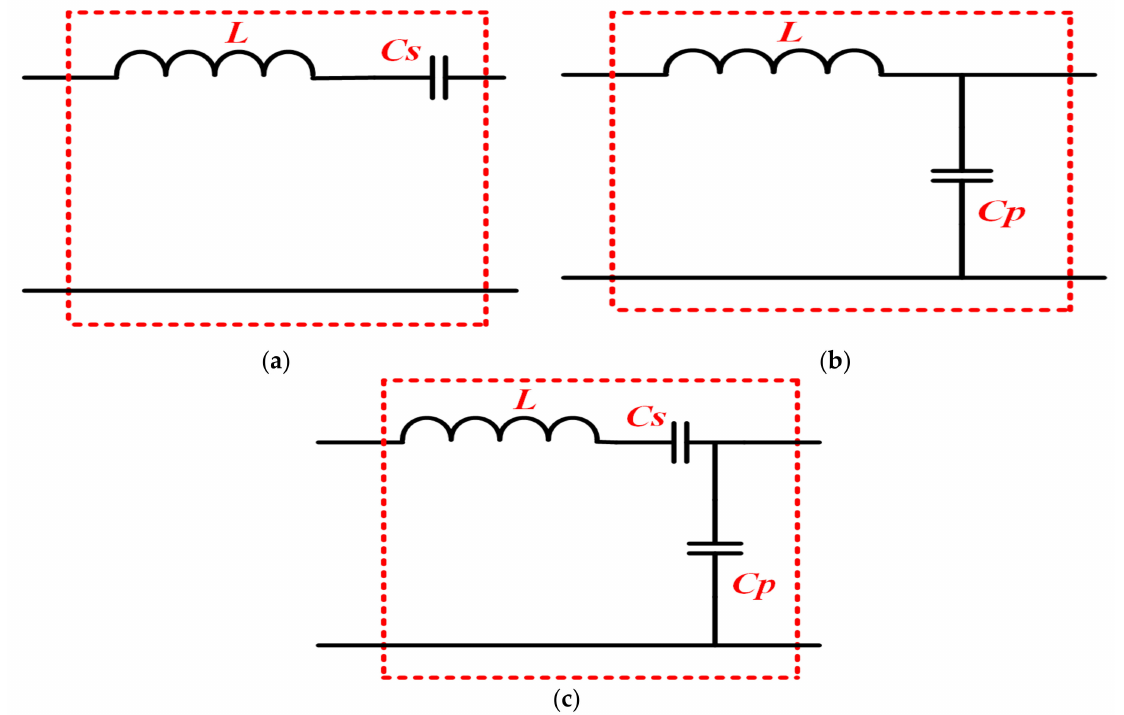
Figure 19. Several types of resonant tank networks: ( a ) Series resonant network; ( b ) Parallel tank network; ( c ) Series-Parallel tank network